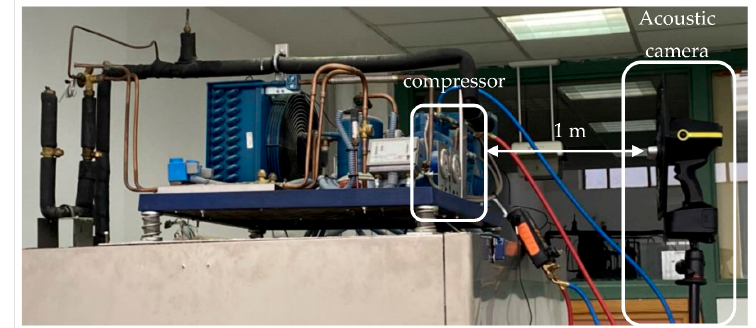
Figure 4. Noise measurement set